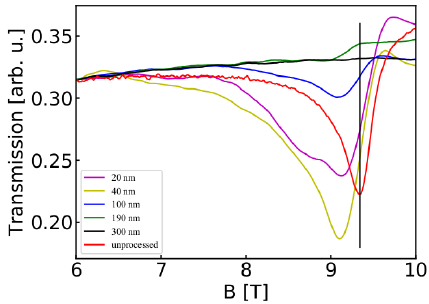
Figure 6. Influence of depth of grooves on transmission. The wavelenght of radiation was 118.8 µ m. Position of the CR in unprocessed sample is indicated with a vertical